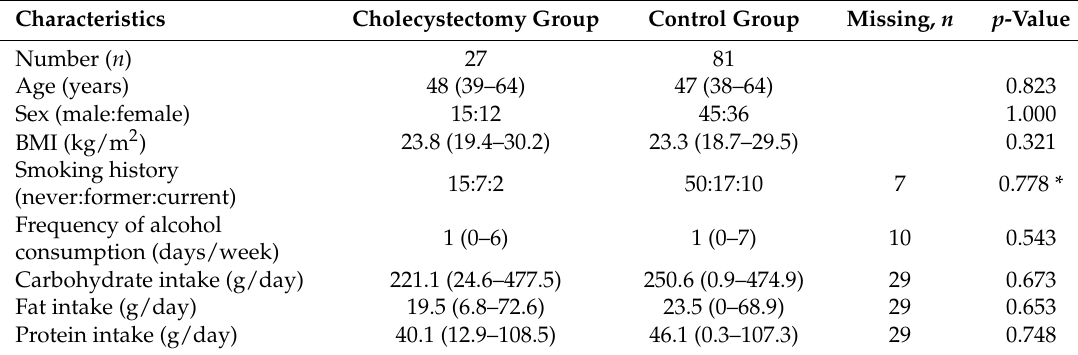
Table 1. Clinical characteristics of the subjects.